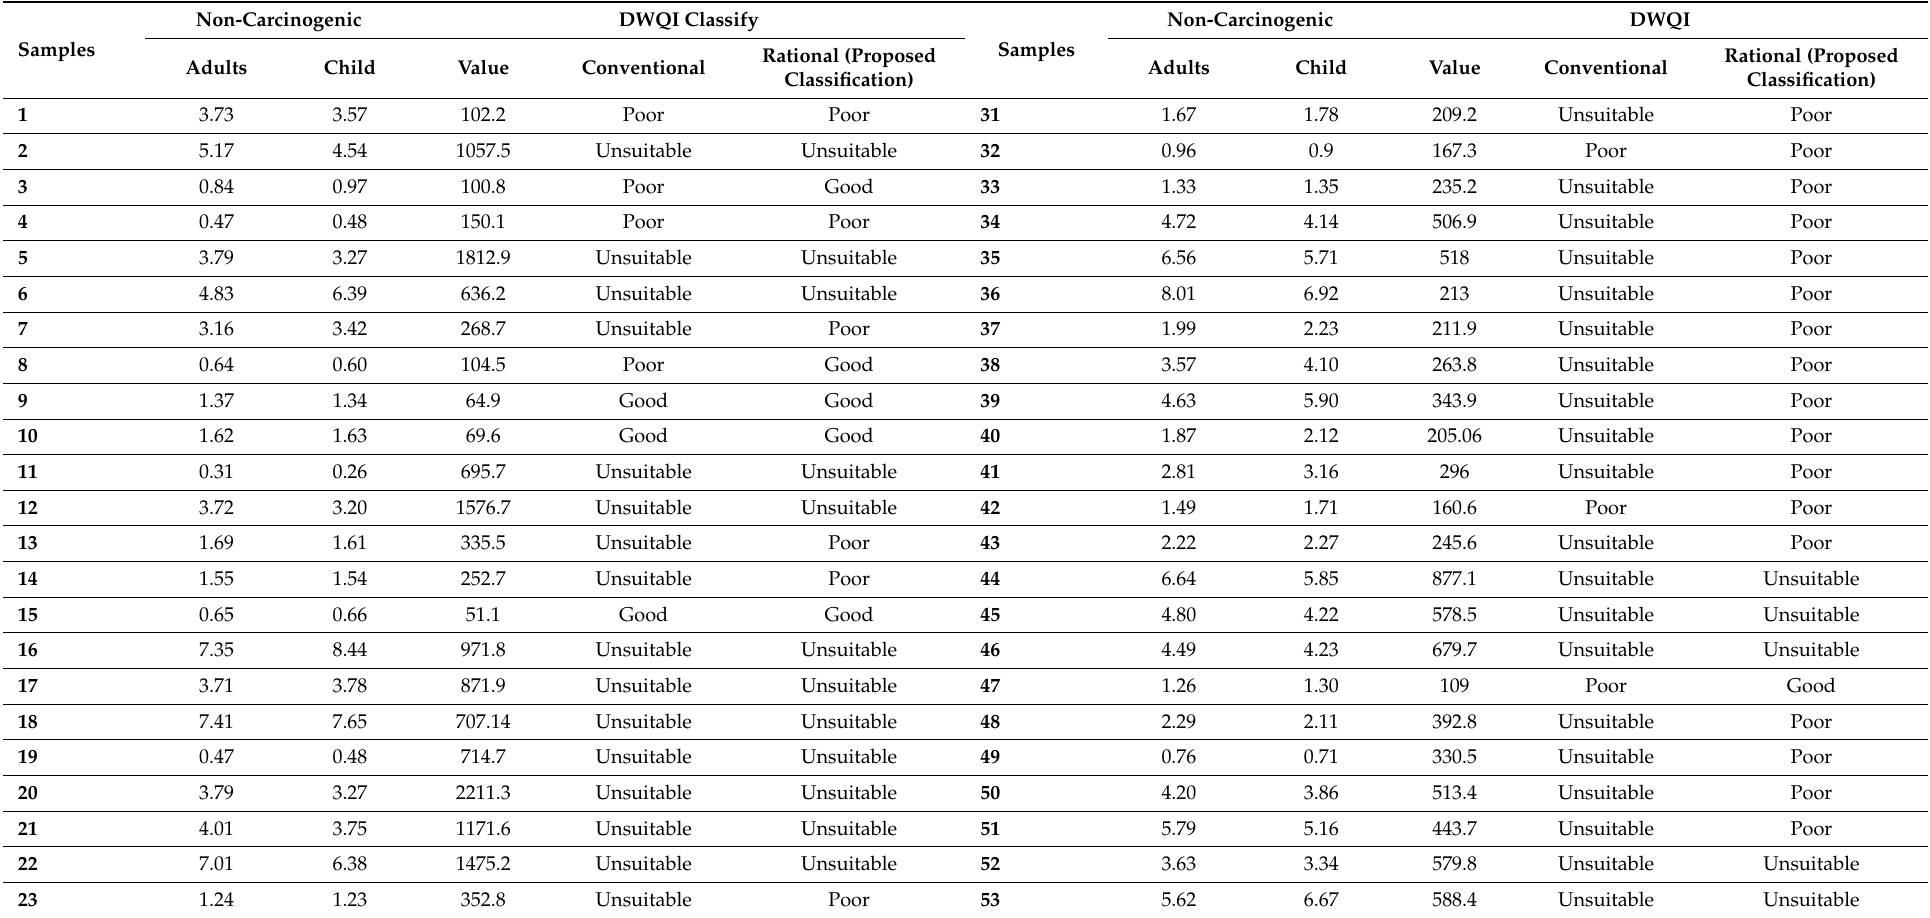
Table 6. Non-carcinogenic HR for adults and children as well as DWQI and corresponding water quality classification of the samples and Correlation Index (CI) between Drinking Water Quality Indices (conventional–rational) and F − -NO 3 − levels at the water